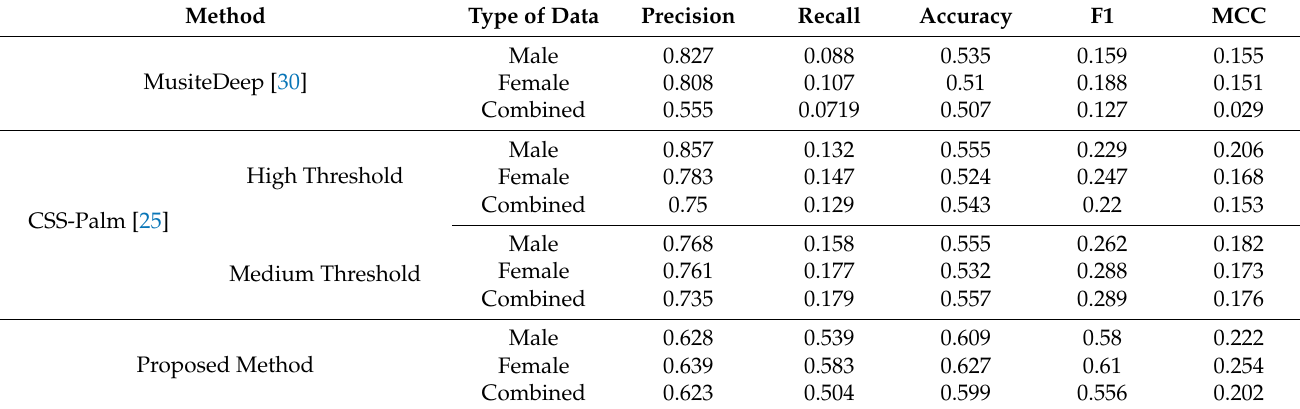
Table 4. Performance comparison with MusiteDeep [24,30] and CSS-Palm [25] web server with holdout dataset. Method Type of Data Precision Recall Accuracy F1